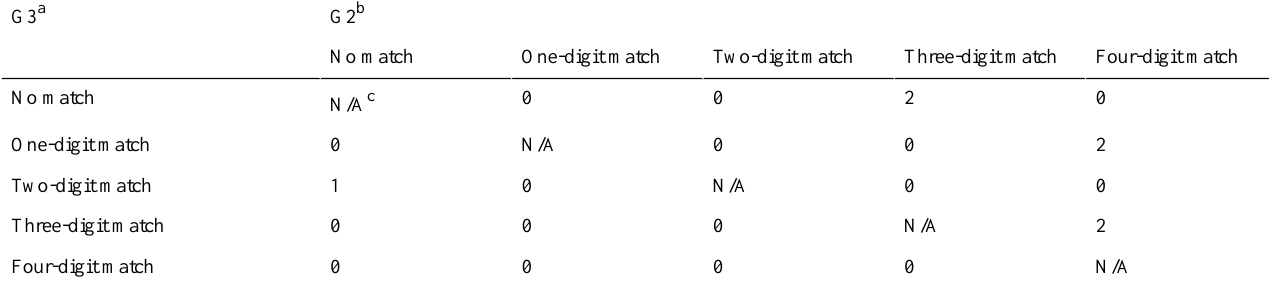
Table 9. Performance of Generation 3 compared with Generation 2.